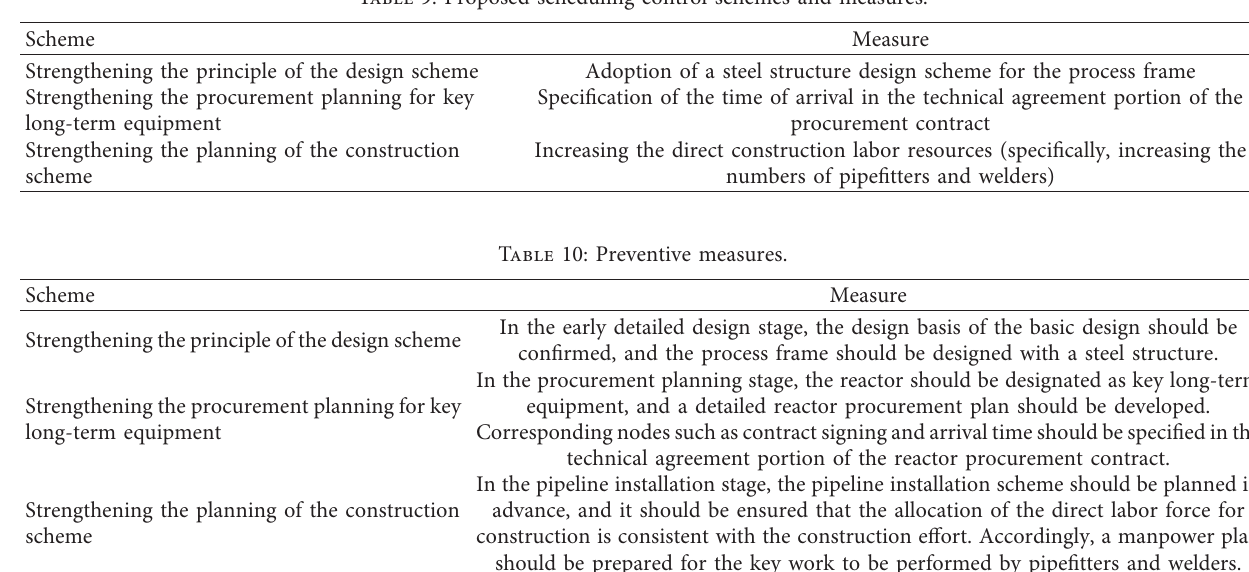
Table S1: feature information for sample industrial project scheduling control cases. Table S2: matrix similarity for